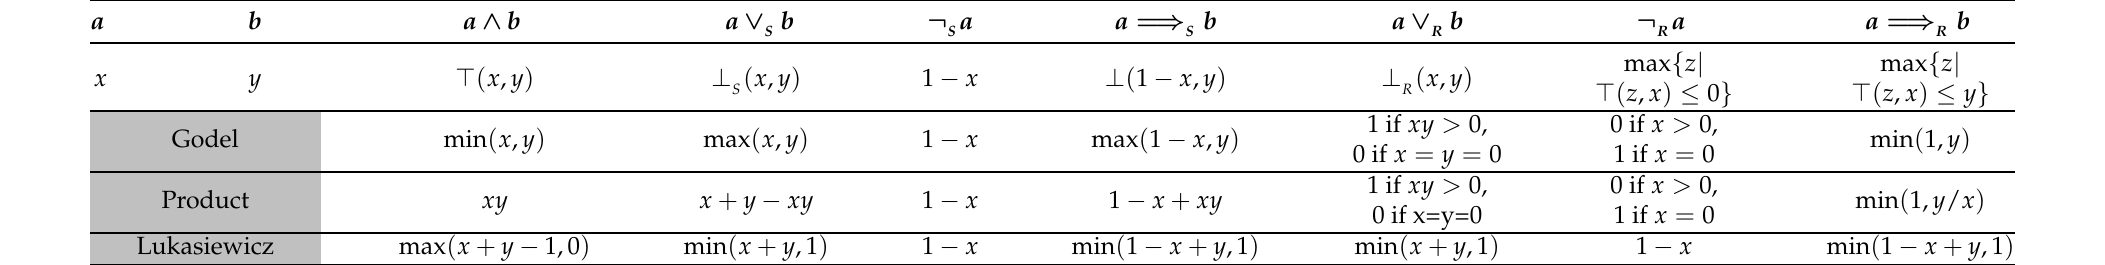
Table 2. Truth tables of t-norm-based IMVLs for the three most common